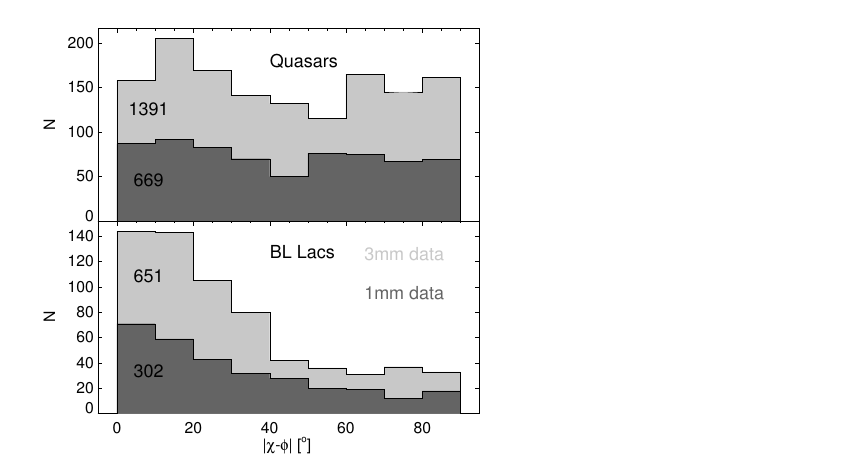
Figure 2. Misalignment between the polarization angle χ and the jet direction φ at 3 and 1 mm wavelengths for quasars and BLLac objects. The polarization angle measurements were taken from [24], while the jet position angles were from [27], except for 0355+508 [30] and for 0235+164, which was taken from the VLBA–BU–BLAZAR program web page; see also [24]. The number of independent 3 and 1 mm observations are indicated for both blazar